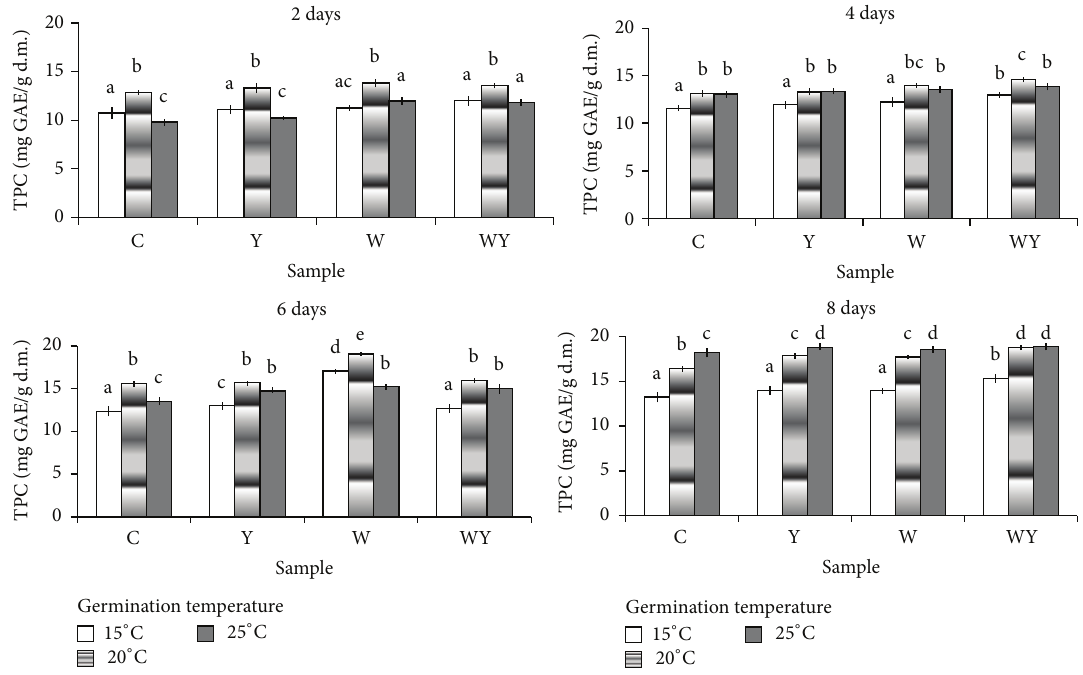
Figure 3: Total phenolics content in control and elicited sprouts depending on time of germination and germination temperature (cv. Muszelka); the values designated by the different letters for individual days of sprouting are significantly different ( 𝛼 = 0.05); C represents control sprouts, Y represents sprouts elicited by yeast, W represents sprouts elicited by willow, and WY represents sprouts elicited by willow/yeast